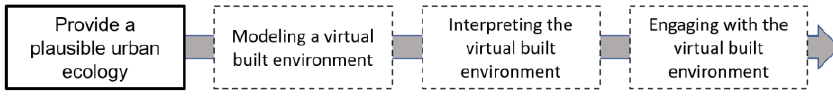
Figure 6. Three steps of considerations towards creating a Plausible Urban Ecology.